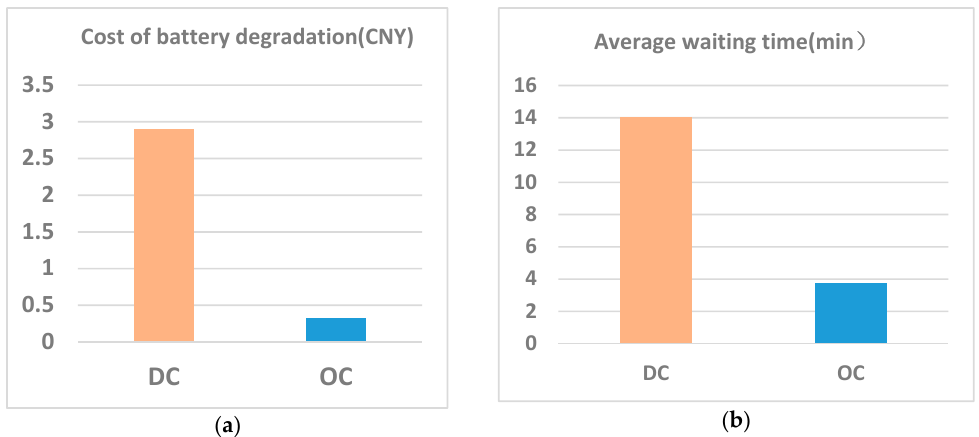
Figure 11. Cost of battery degradation and average waiting time comparison of ordered charging and disordered charging: ( a ) cost of battery degradation; and ( b ) average waiting time.